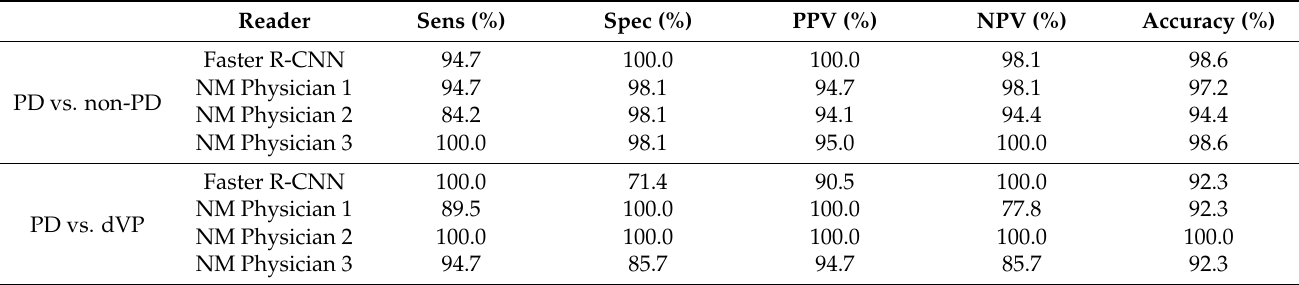
PD, idiopathic Parkinson’s disease; dVP, definite vascular parkinsonism with prominent defect or decreased dopamine transporter binding mimicking PD; Faster R-CNN, faster region-based convolutional neural network; Sens, sensitivity; Spec, specificity; PPV, positive predictive value; NPV, negative predictive value; NM, nuclear